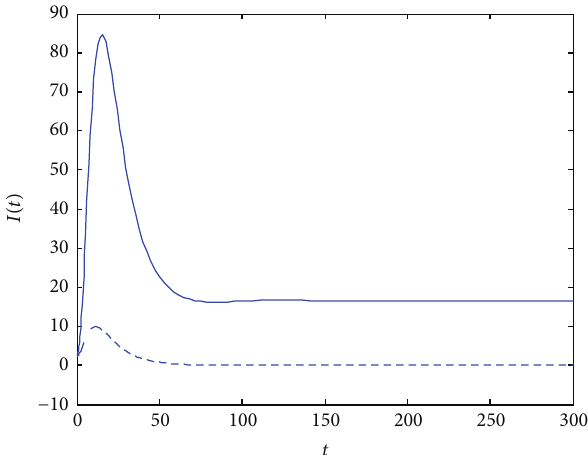
Figure 3: Variation of the number of infected under different 𝜆 . The solid line represents the case when 𝜆 = 0.05 , and the dashed line represents the case when 𝜆 = 0.5